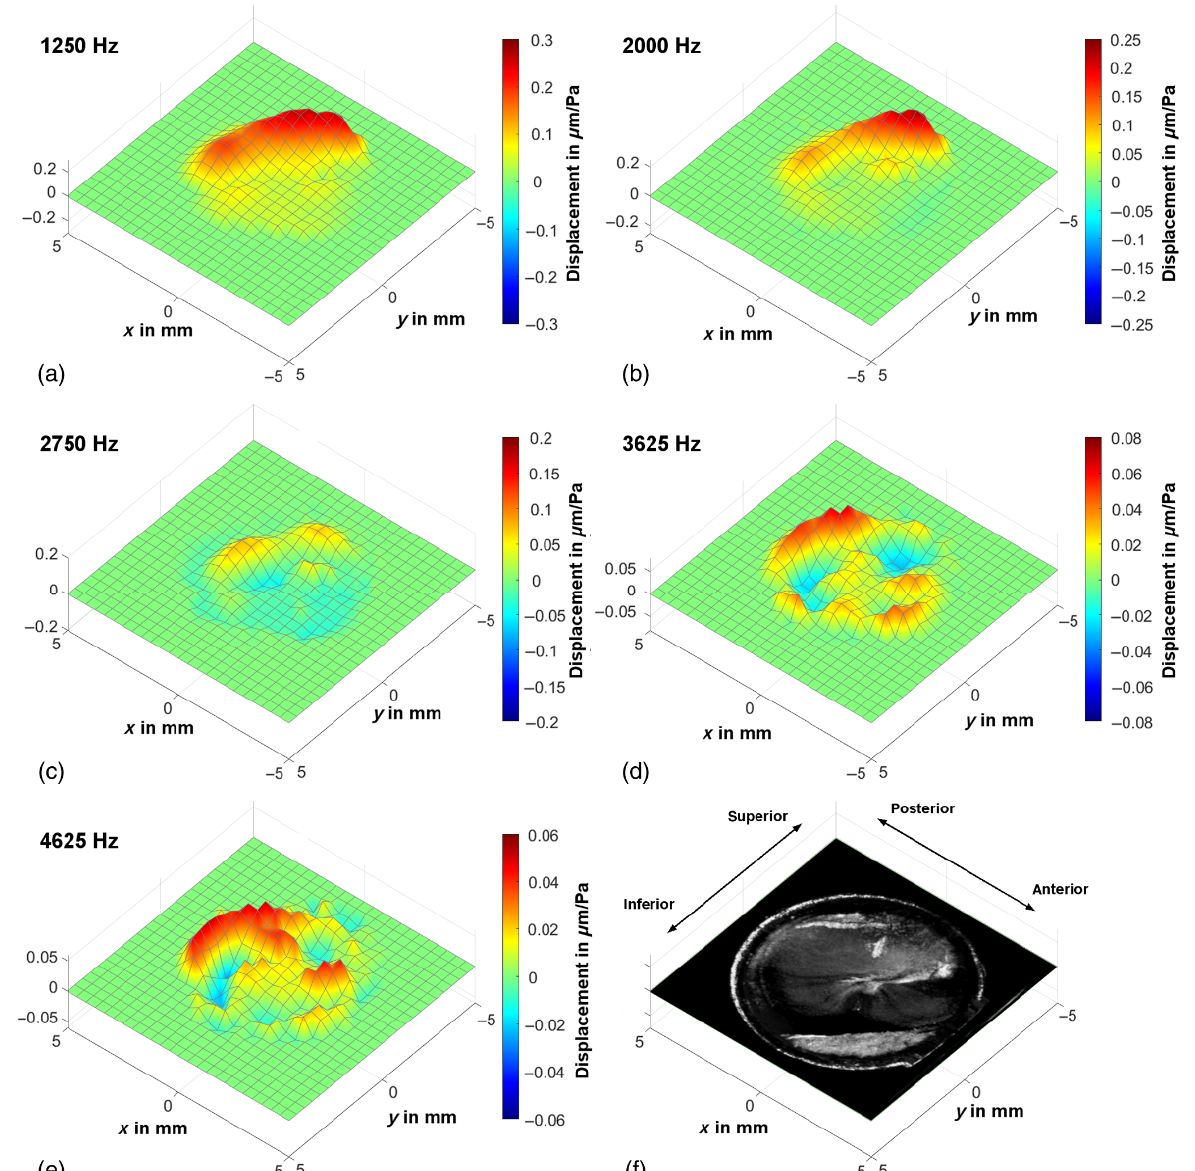
Figure 8. ( a – e ) Exemplary oscillation patterns in vivo at characteristic frequencies, which were calculated by postprocessing of one functional OCT measurement, show the deflection of the tympanic membrane. The displacement scale and color map are adjusted to the maximum amplitude of each oscillation pattern. ( f ) Depth projection of the corresponding OCT volume scan for comparison. The x and y scales are applicable for the working distance of 8 mm. Reprinted with permission from Ref. [50].